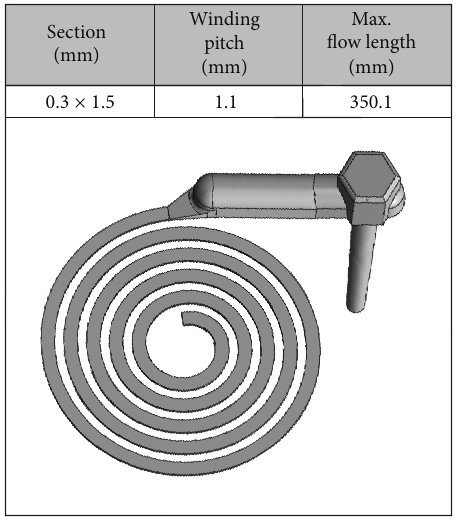
Figure 1: Used microflow spiral for the